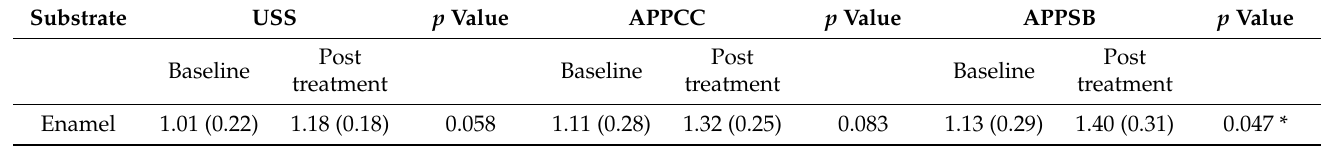
Table 3. Mean Ra values ( µ m) of the enamel before and after hygiene maintenance procedures, M ( σ ).